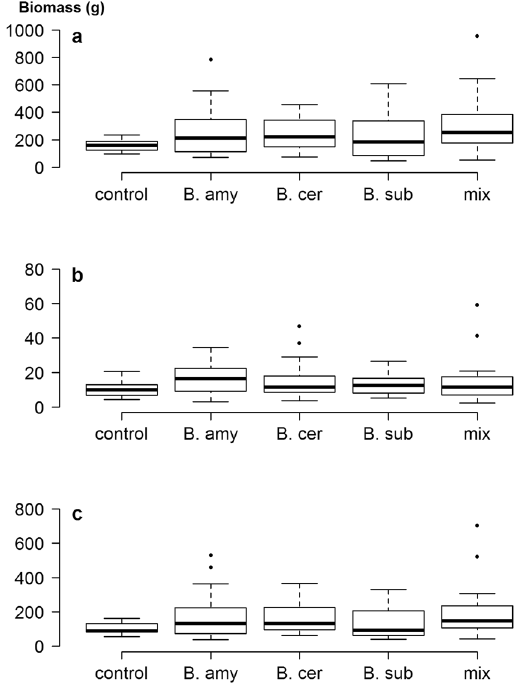
Figure 3. Box plots showing the range in size distributions for ( a ) total biomass, ( b ) root biomass and ( c ) shoot biomass of calabrese plants grown in UK field soil, with and without the addition of plant growth-promoting rhizobacteria. Addition of PGPR indicated by: B. amy: Bacillus amyloliquefaciens ; B. cer: B . cereus ; B. sub: B . subtilis ; mix: mixture of all three